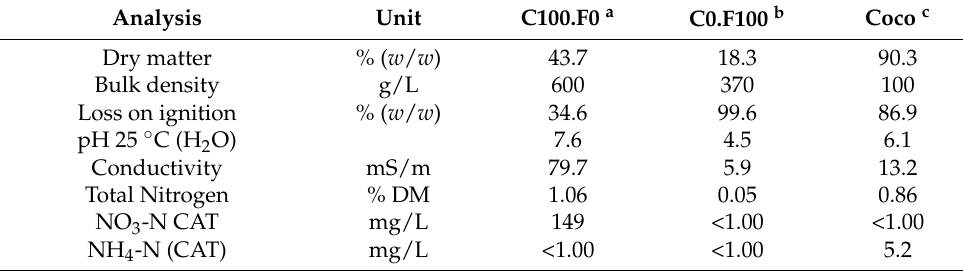
Table 3. Selected chemical properties of treatments in Experiment